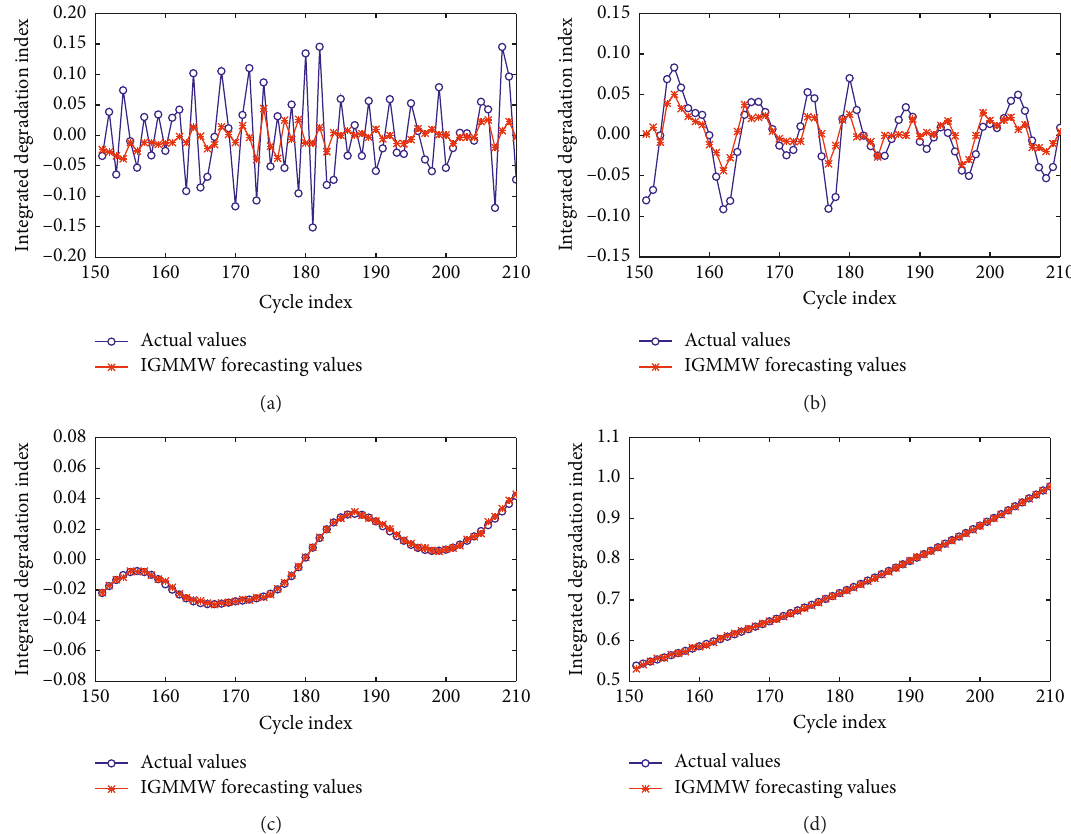
Figure 11: Comparisons of actual IDI and IGMMW forecasting values for four RIMFs: (a) RIMF1, (b) RIMF2, (c) RIMF3, and (d)